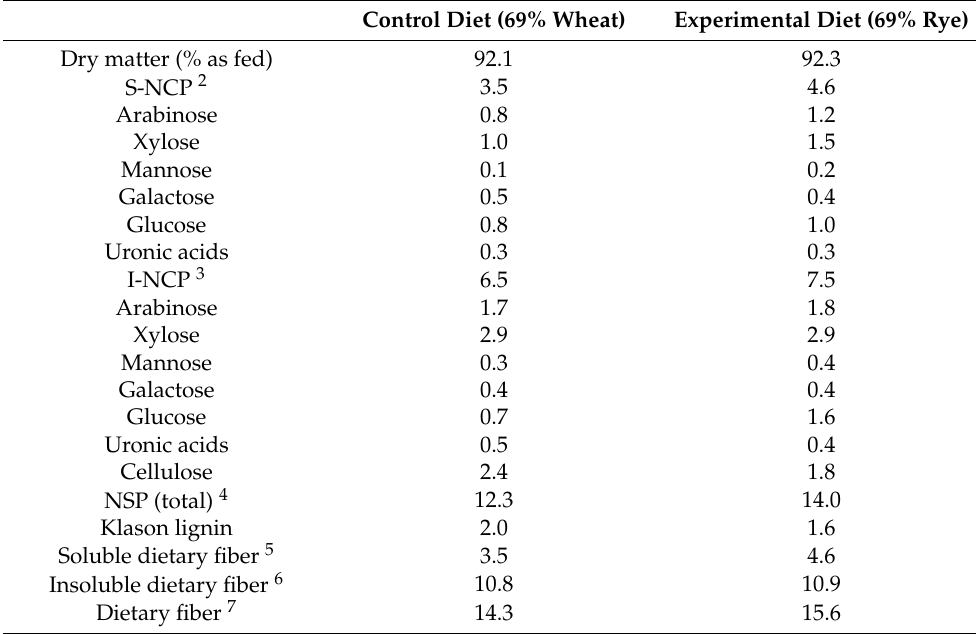
Table 2. Carbohydrate composition of compound feeds (%, dry matter basis) 1